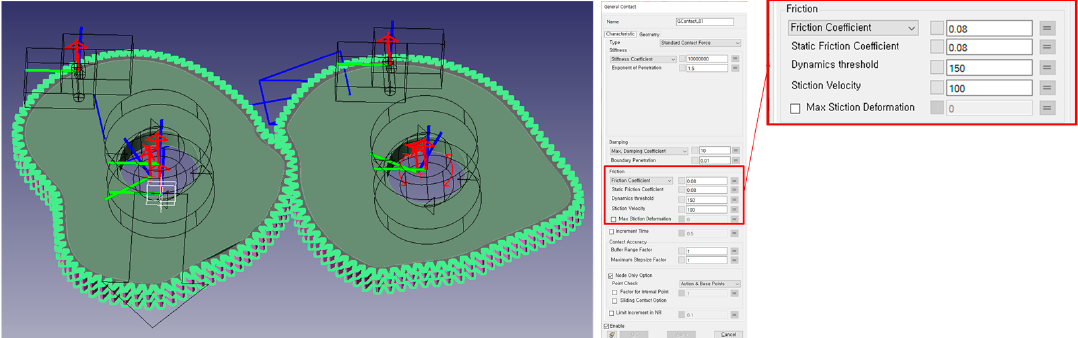
Figure 16. Contact condition setting for non-circular gears.